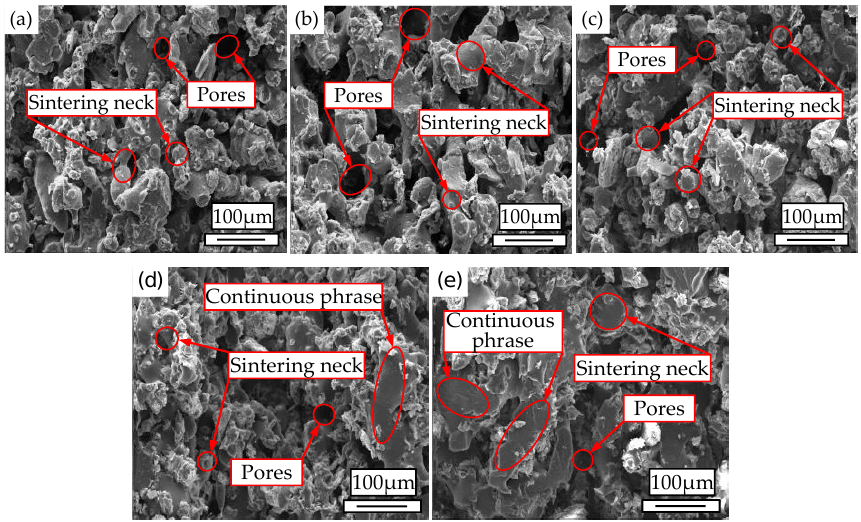
Figure 7. Scanning electronic microscopy (SEM) images of cross sections of the WSPC parts at the preheating temperature of 92 °C with walnut shell/Co-PES/Co-PA powder of ( a ) 40%/58%/0%; ( b ) 40%/50%/8%; ( c ) 40%/29%/29%; ( d ) 40%/18%/40%; ( e ) 40%/0%/58%. The SEM images of cross sections of the WSPC parts with walnut shell/Co-PES/Co-PA powder of 40%/50%/8% at different preheating temperatures are shown in Figure 8. Figure 8a,b show that the size and quantity of the inner pores of the WSPC parts were large, and the size and quantity of the sintering necks were small. The main reason is that at lower preheating temperatures, the laser energy